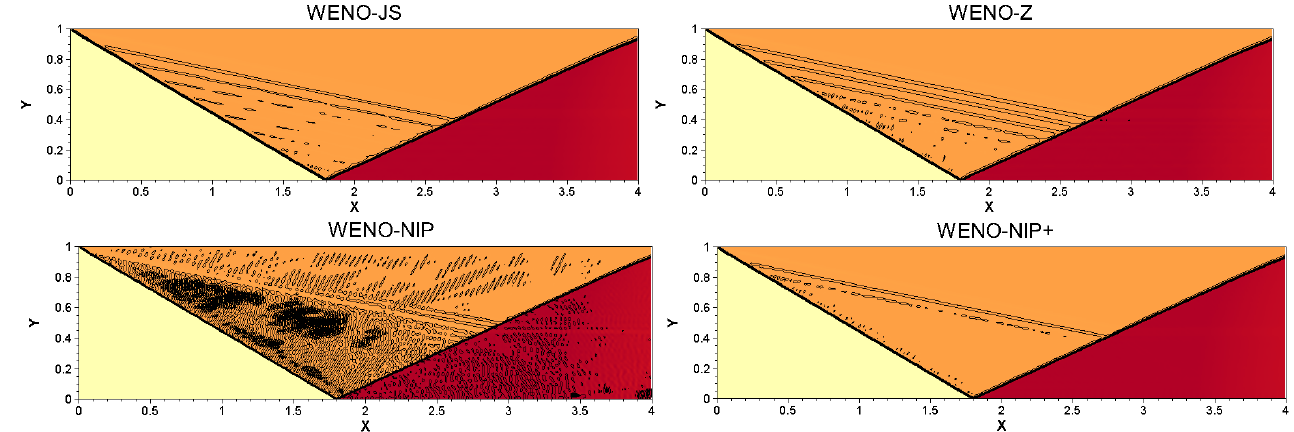
Figure 24. Density contours of the regular shock reflection of WENO-JS, WENO-Z, WENO-NIP, and WENO-NIP+ using 30 contour lines with a range from 1.05 to 2.7. Left upper corner, WENO-JS. Right upper corner, WENO-Z. Left lower corner, WENO-NIP. Right lower corner,